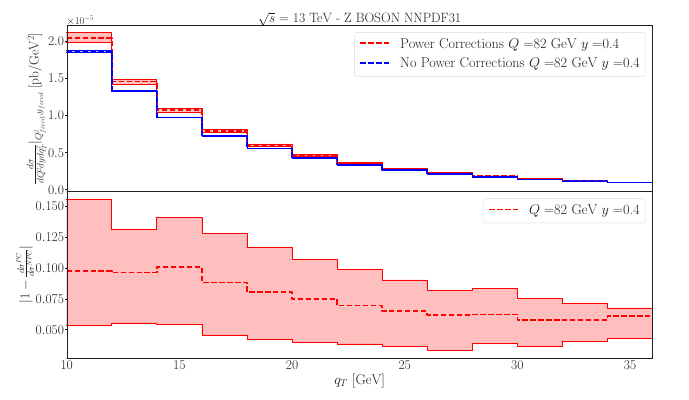
Figure 2. Comparison between theory predictions using our modified TMD factorization framework, with and without the power corrections that we can account